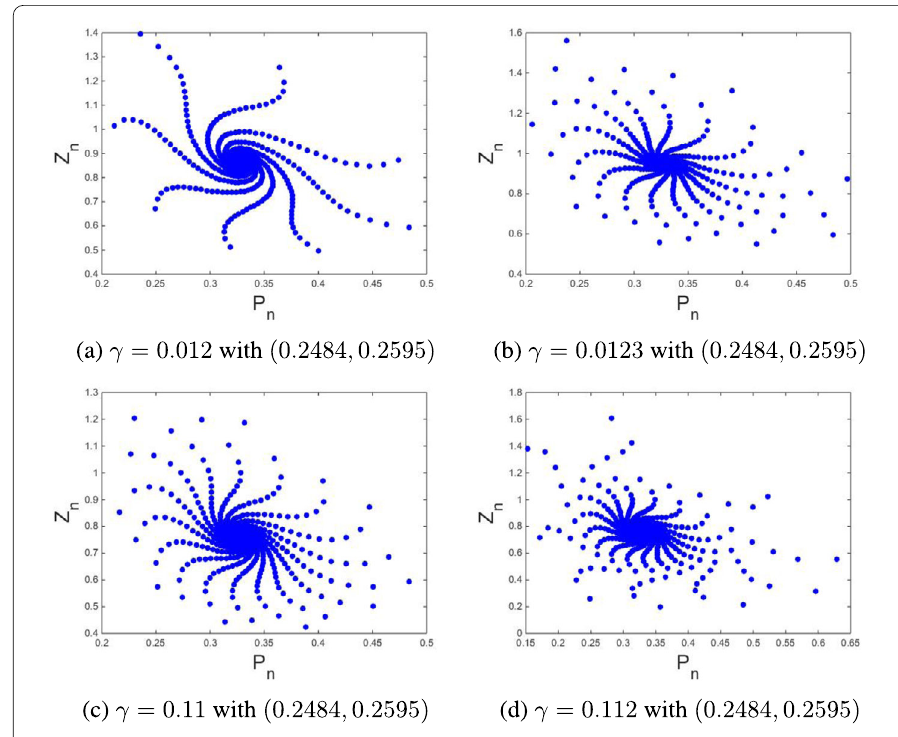
Figure 4 Stable node of phytoplankton–zooplankton model (8)